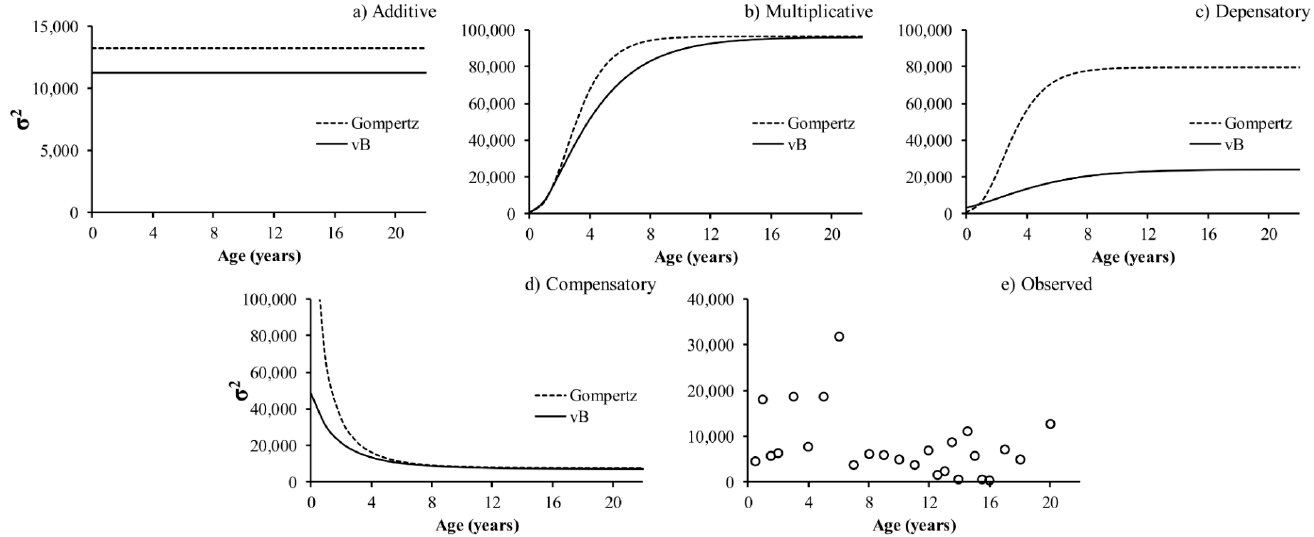
Figure 1. Variance of size at age ( σ 2 ) for the von Bertalanffy (vB) and Gompertz growth models and observed variance. ( a ) additive variance, ( b ) multiplicative variance, ( c ) depensatory variance, ( d ) compensatory variance, ( e ) observed variance. Table 1. Results of comparing variance of length ‐ at ‐ age. θ j is the number of parameters in each model, n is the sample size or the number of age ‐ length pairs, Wj is the weight of the model, and j refers to the number of parameters in each model.